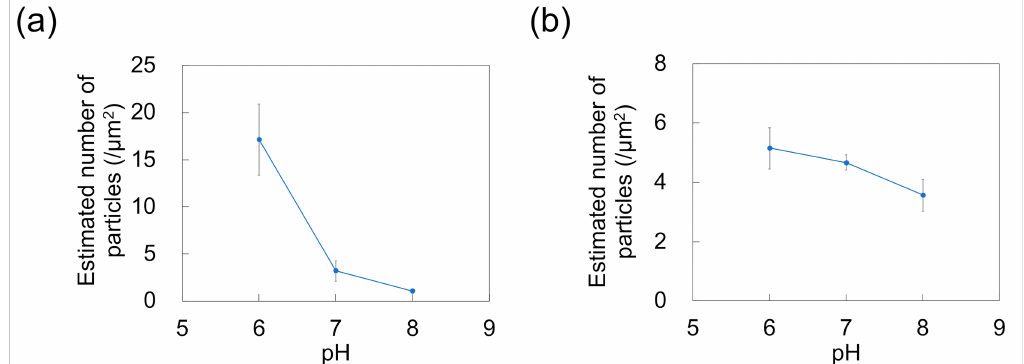
Figure 8. Effect of pH on the number of particles adsorbed on polydimethylsiloxane-based microchannels exposed to dispersions of ( a ) 100-nm and ( b ) 250-nm nanoparticles ( n = 5) at a flow rate of 0.7 mL/h. Error bars represent the standard